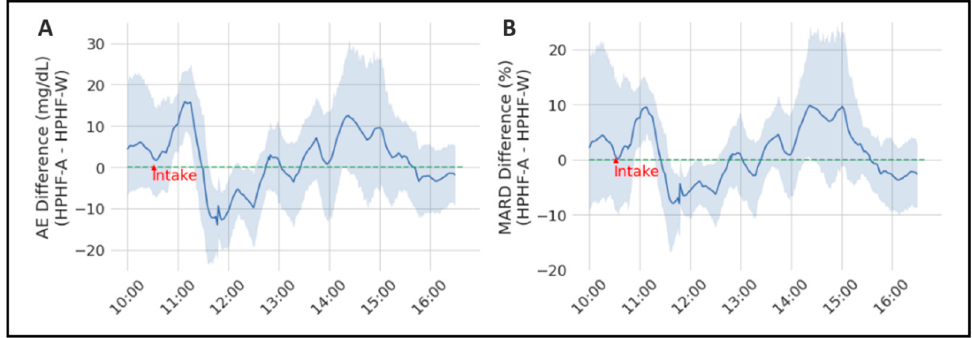
Figure 2. Representation of the mean AE (panel ( A )) and MARD differences (panel ( B )) between both considered studies (HPHF-A and HPHF-W). The grey area represents the 95% CI. Table 4. Statistical main indicators for pH_L1, pH_L2, PA_L1 and PA_L1 by Level value (Low and High), besides of the Mann–Whitney U test results for each variable of